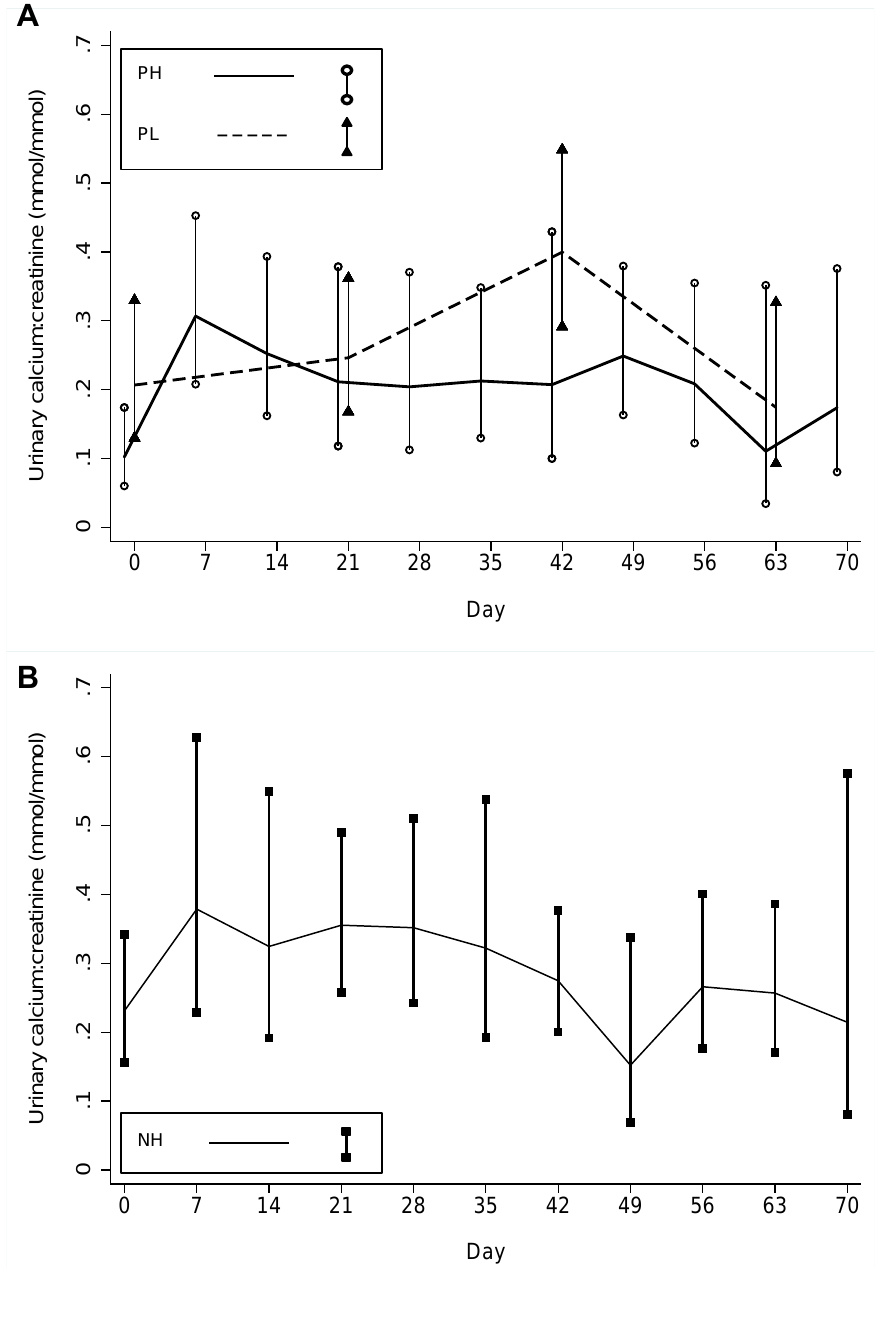
Figure 7. Mean urine calcium:creatinine ratio in the three participant groups.( A ) Mean urine calcium:creatinine ratio in pregnant participants who received an initial dose of 70,000 IU and then 35,000 IU/week (PH) and pregnant participants who received a weekly dose of 14,000 IU/week (PL), and ( B ) Mean urine calcium:creatinine ratio in non-pregnant participants who received an initial dose of 70,000 IU and then 35,000 IU/week (NH). Vertical bars represent the 95% confidence intervals of the means at each scheduled follow-up